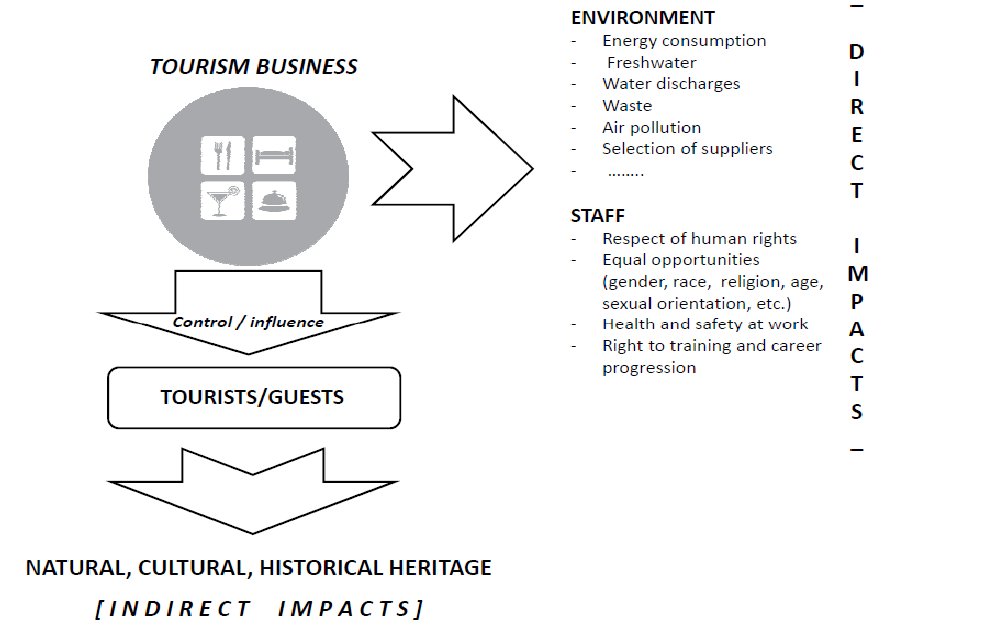
Figure 1: The Tourism